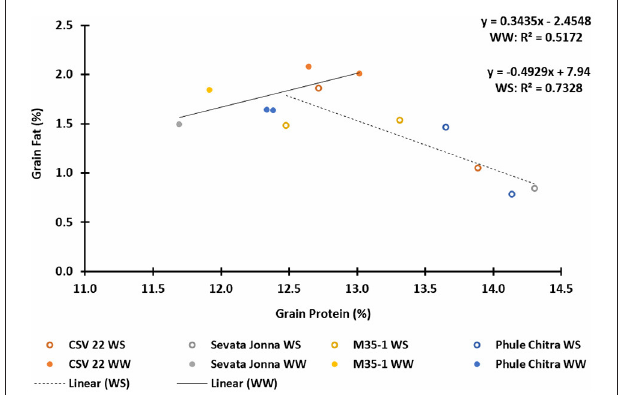
FIGURE 5 | Trait relationship between grain yield (g plant − 1 ) and leaf senescence at 80 DAS in water stressed (WS) plants of four sorghum varieties tested in 2019–20 lysimetric trial. Crop varieties are color coded; Open circles (O) indicate WS plants; solid line (–) indicated relationship between the traits.